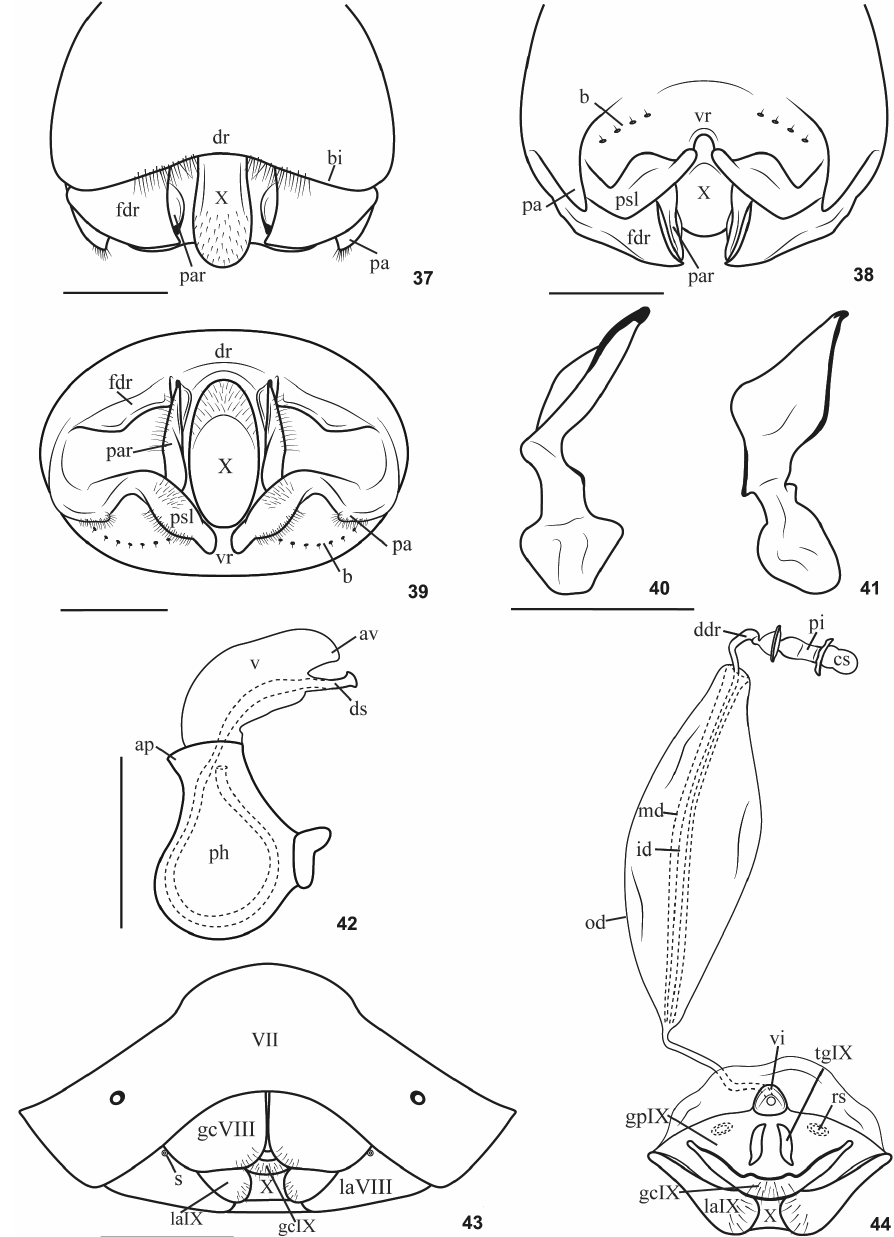
Figures 37–44. Lineostethus graziae : (37–39) male pygophore, dorsal, ventral and posterior views respectively; (40–41) left paramere, dorsal and lateral views; (42) phallus, lateral view; (43) female genital plates; (44) female receptaculum seminis. Abbreviations: ap, ventral apical projection of phallotheca; av, apical margin of vesica; b, bristles; bi, basal impression of foliaceous expansions; cs, capsula seminalis; ddr, distal ductus receptaculi; dr, dorsal rim; ds, ductus seminis distalis; fdr, foliaceous expansions of dorsal rim; gcVIII, gonocoxites VIII; gcIX, gonocoxites IX; gpVIII, gonapophyses VIII; gpIX, gonapophyses IX; id, internal duct of vesicular area; la8, laterotergites VIII; la9, laterotergites IX; md, median duct of vesicular area; od, outer duct of vesicular area; pa, posterolateral angle; par, paramere; ph, phallotheca; pi, pars intermedialis; psl, projection of superior layer of ventral rim; rs, ring sclerites; s, spiracle; tgIX, thickening of gonapophyses IX; v, vesica; vi, thickening of vaginal intima; vr, ventral rim; VII, urosternite VII; X, segment X. Scale bars: 37–41, 43 = 1 mm; 42, 44 =